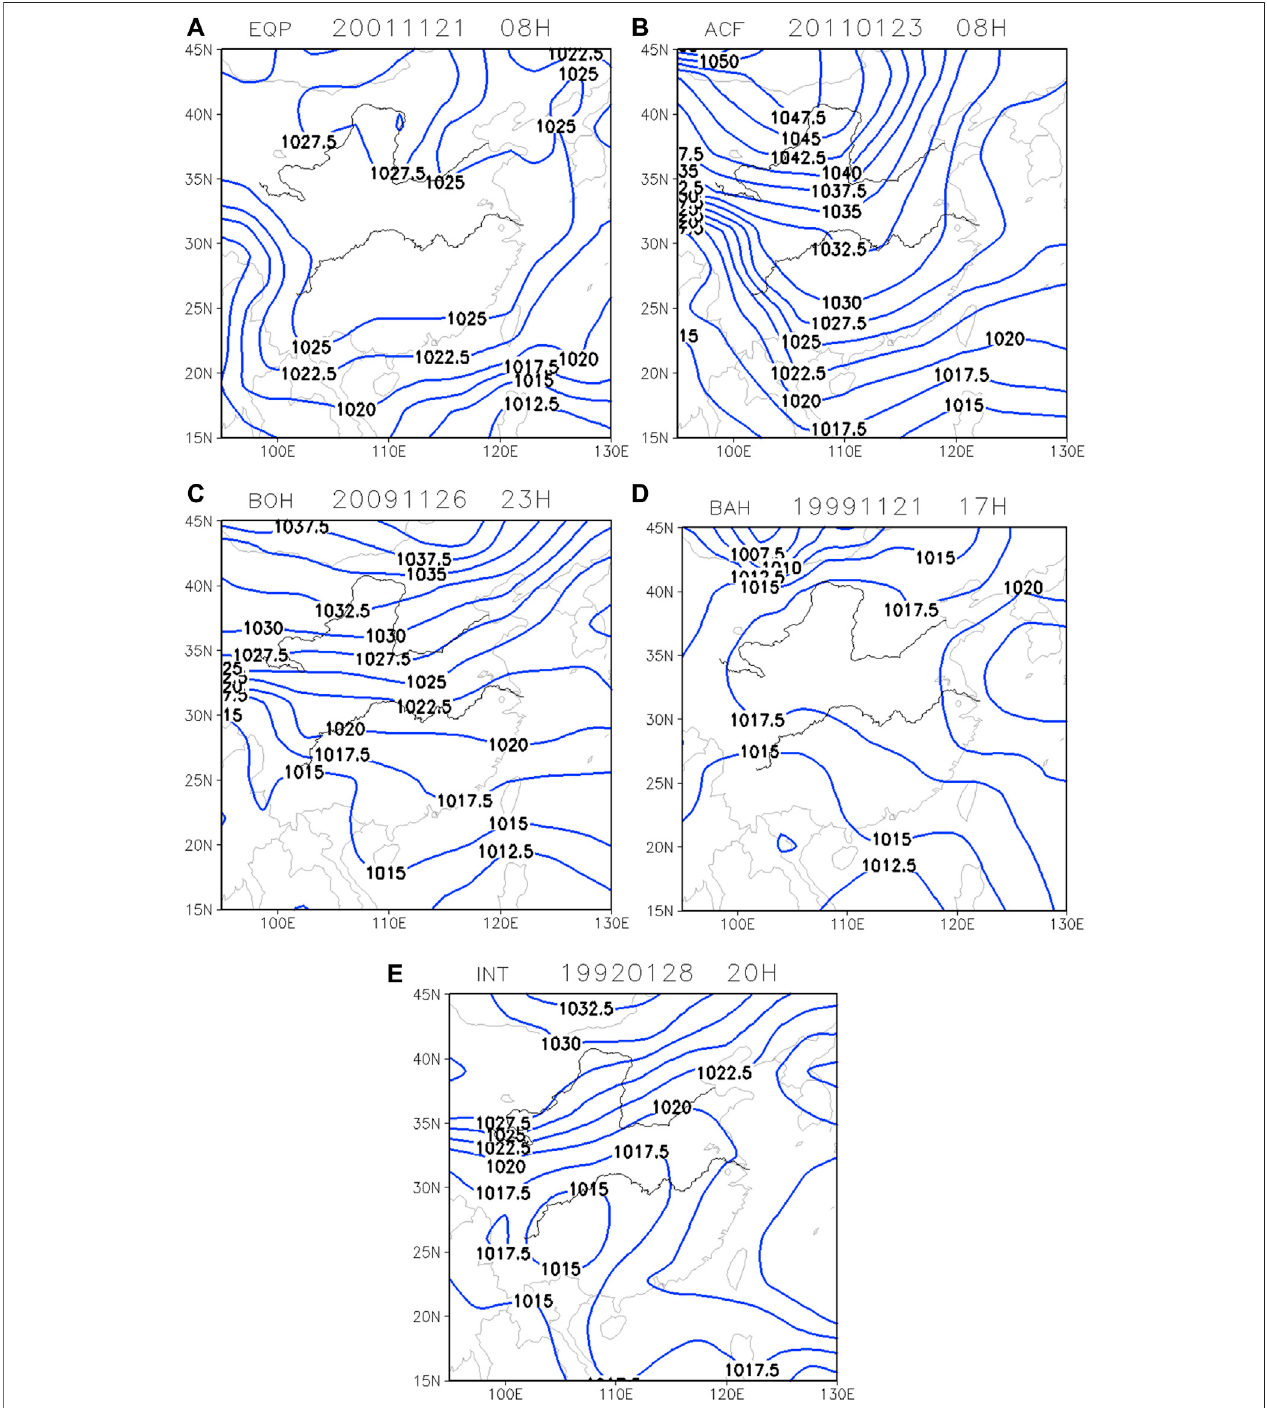
FIGURE3| Surfaceconditionsonheavyhazedays.Theyare (A) equalizedpressure fi eld(EQP), (B) advancingedgeofacoldfront(ACF), (C) baseofhighpressure (BOH), (D) backside of high pressure (BAH), and (E) inverted trough (INT).